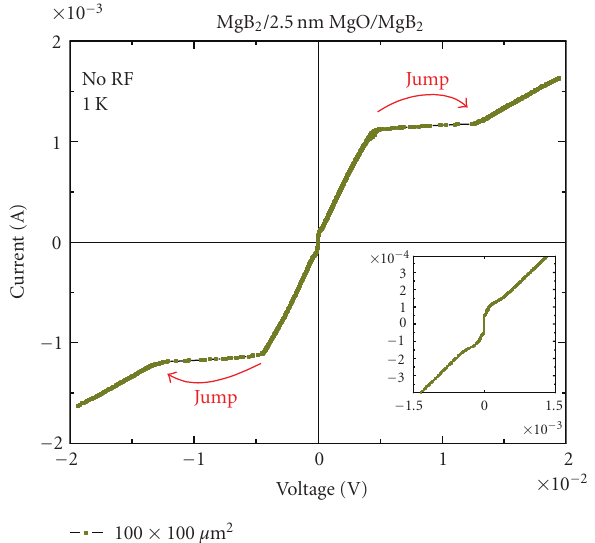
Figure 9: Current-voltage measurement for an all-MgB 2 junction with a sputtered MgO barrier. The data was collected in constant- current mode. The jump occurring at ± 12 . 7 mV corresponds to tunneling between the MgB 2 σ -gaps.